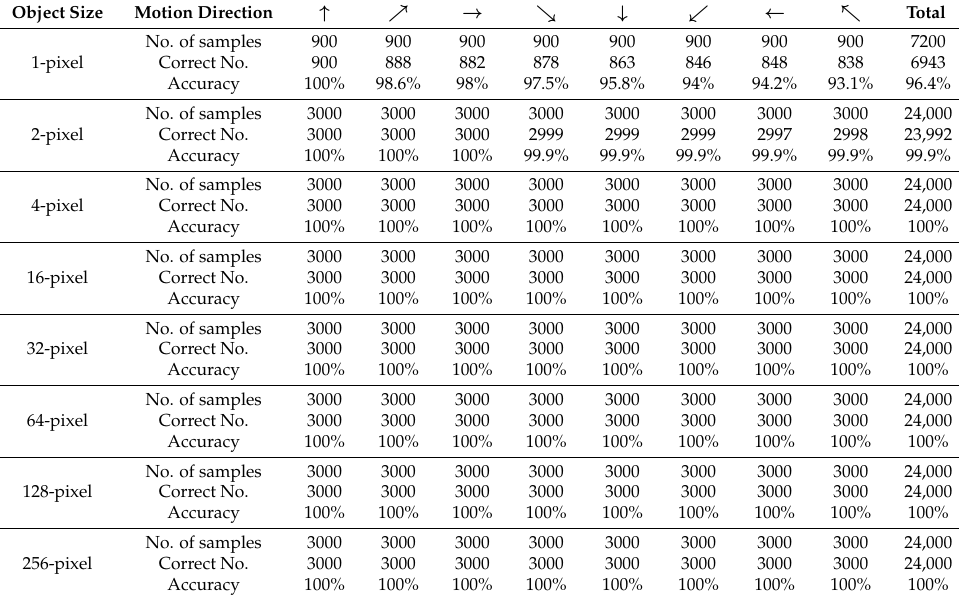
Figure 10. Experiments of a 32 pixel sized rectangular object on a greyscale background with random directional motion. ( a ) here represent the state of the object before motion movement, and the state of the object after motion movement. ( b ) here represents the location as well as number of times the eight kinds of LDDNs were activated. Table 1. Experimental results of LDDN and GDDN on motion direction detection with different scales of objects.The table mainly consists of the data on object size, motion direction and accuracy, which the arrows representing the eight different motion